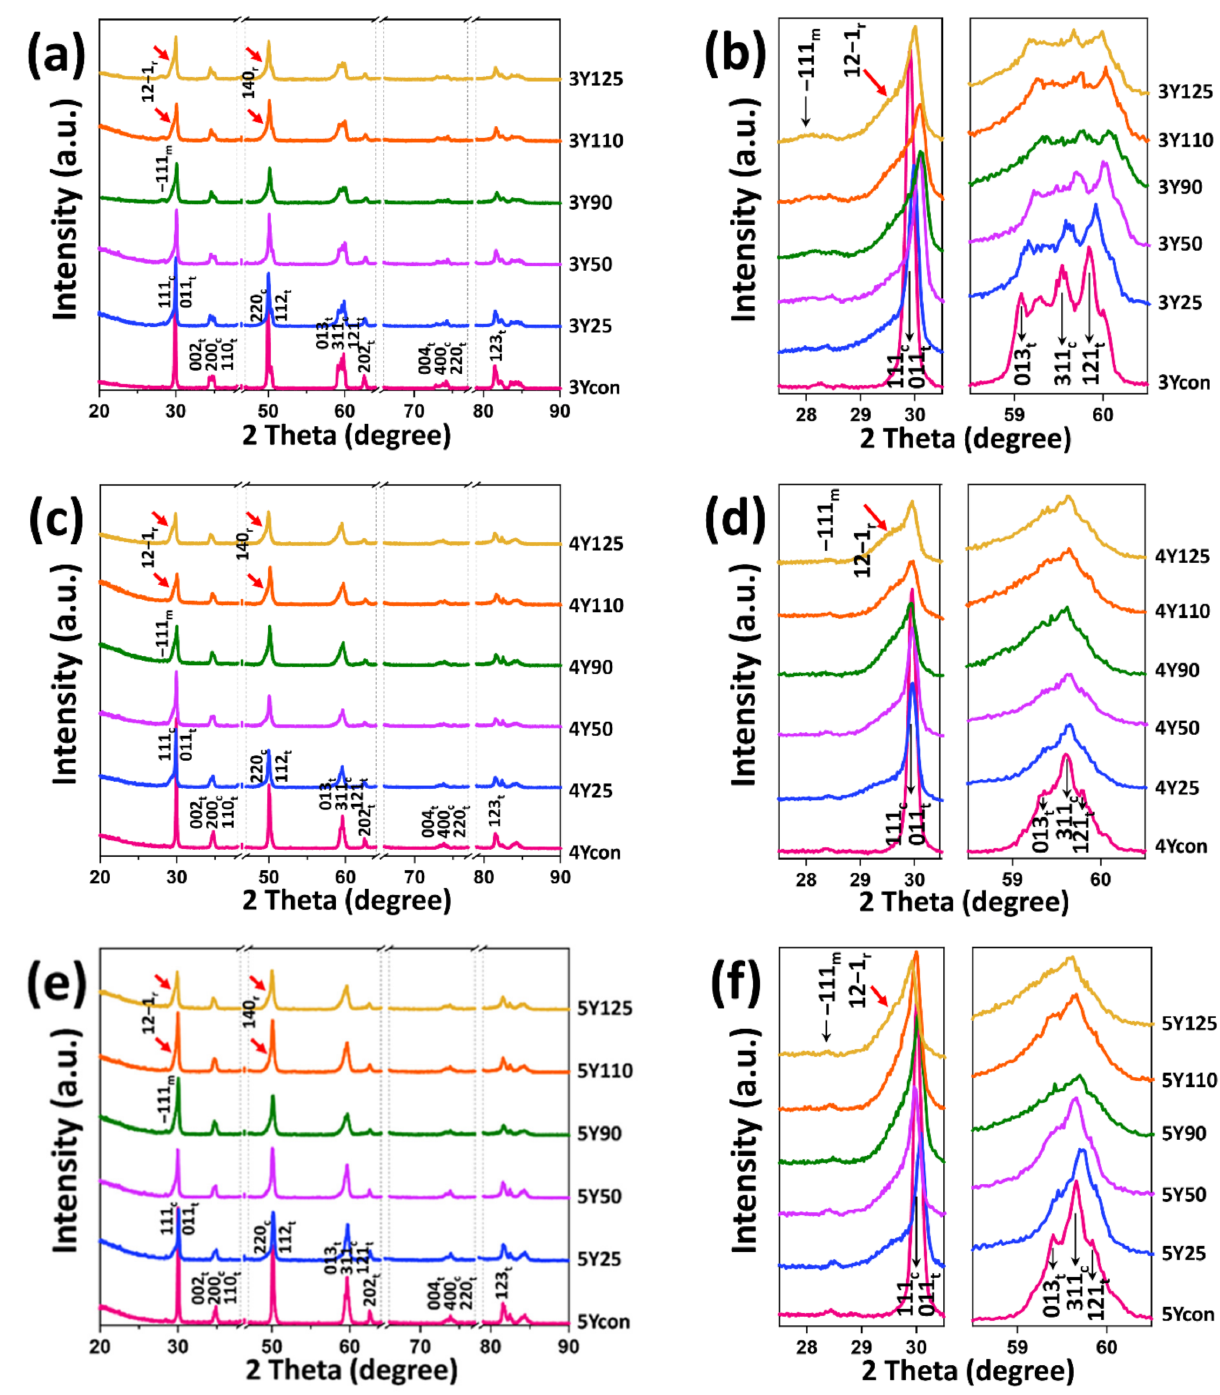
Figure 4. X-ray diffraction (XRD) patterns of subgroups subjected to sandblasting with different size of alumina particles for 3 mol% yttria-stabilized tetragonal zirconia polycrystal: ( a ) in the 2 θ range of 20–90 ◦ , ( b ) the enlarged graphs in the range 27.5 < 2 θ < 30.5 and 58.5 < 2 θ < 60.5; for 4 mol% partially stabilized zirconia: ( c ) in the 2 θ range of 20–90 ◦ , ( d ) the enlarged graphs in the range 27.5 < 2 θ < 30.5 and 58.5 < 2 θ < 60; and for 5 mol% partially stabilized zirconia: ( e ) in the 2 θ range of 20–90 ◦ , ( f ) the enlarged graphs in the range 27.5 < 2 θ < 30.5 and 58.5 < 2 θ < 60.5. The control groups had tetragonal and cubic crystal phases. After sandblasting, the appearance of monoclinic phase peak ( − 111) at 2 θ = 28.2 ◦ and rhombohedral phase peak (12 − 1) at 2 θ = 29.88 were identified in three zirconia grades. m: monoclinic phase; t: tetragonal phase; c: cubic phase; r: rhombohedral